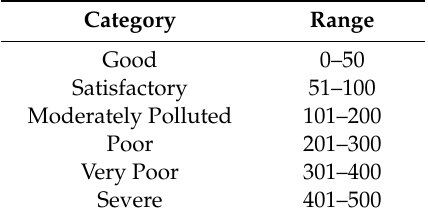
Table 1. (National Air Quality Index, CPCB, October